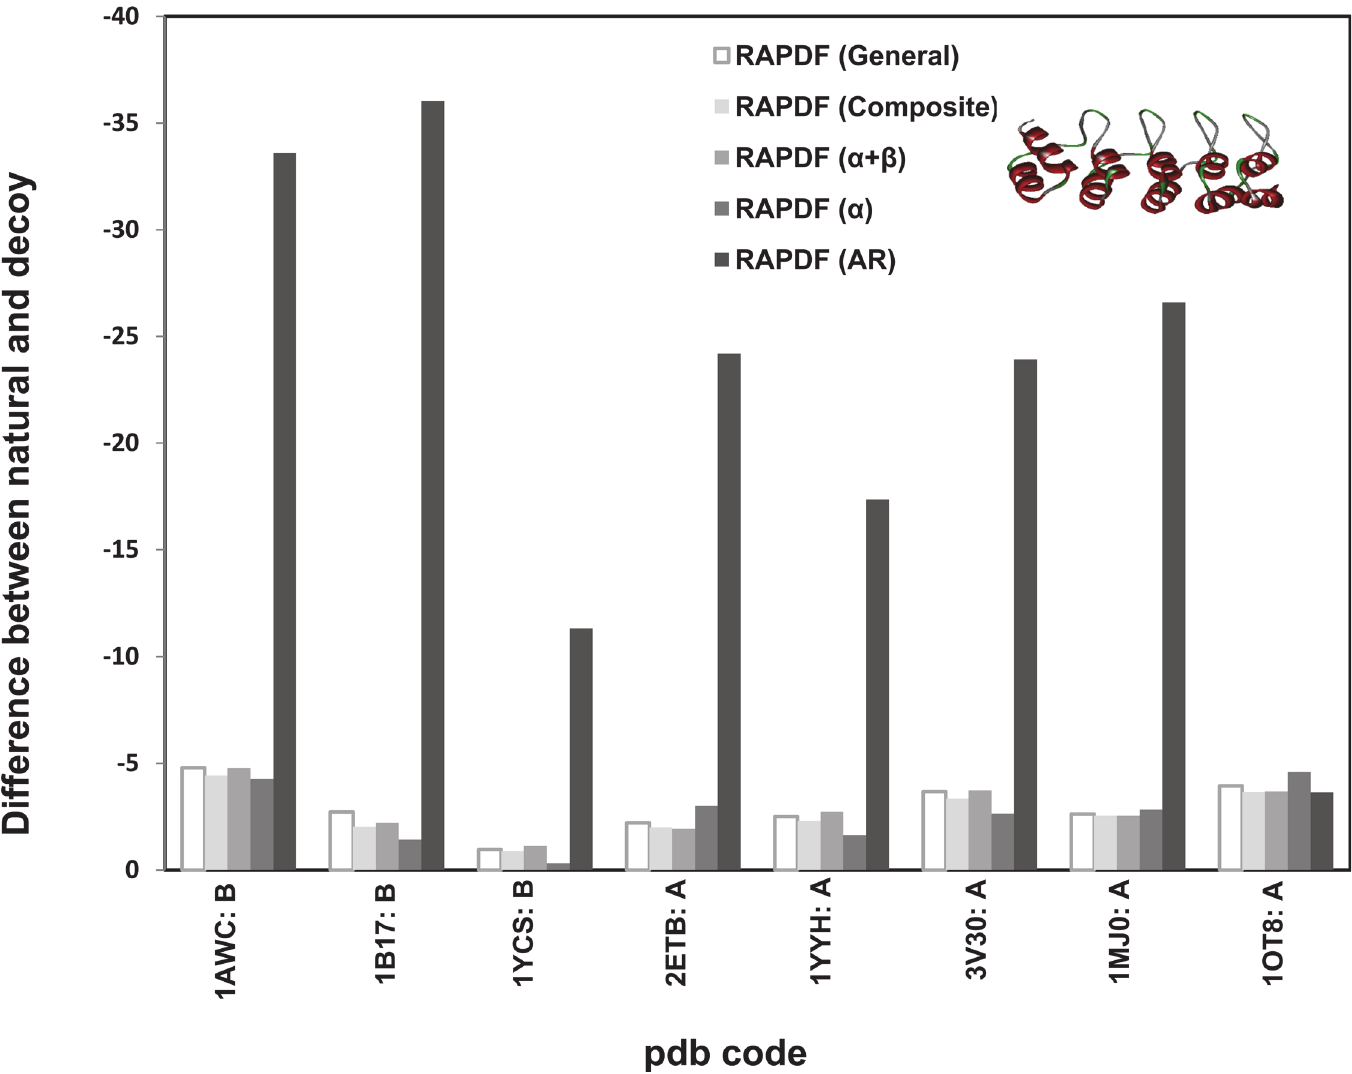
Fig 6. Distance-dependant statistical potential based on ankyrin repeat protein library (33 proteins) . Homology models were used as decoys. RAPDF (Ankyrin) represents the statistical RAPDF scores calculated using the Ankyrin